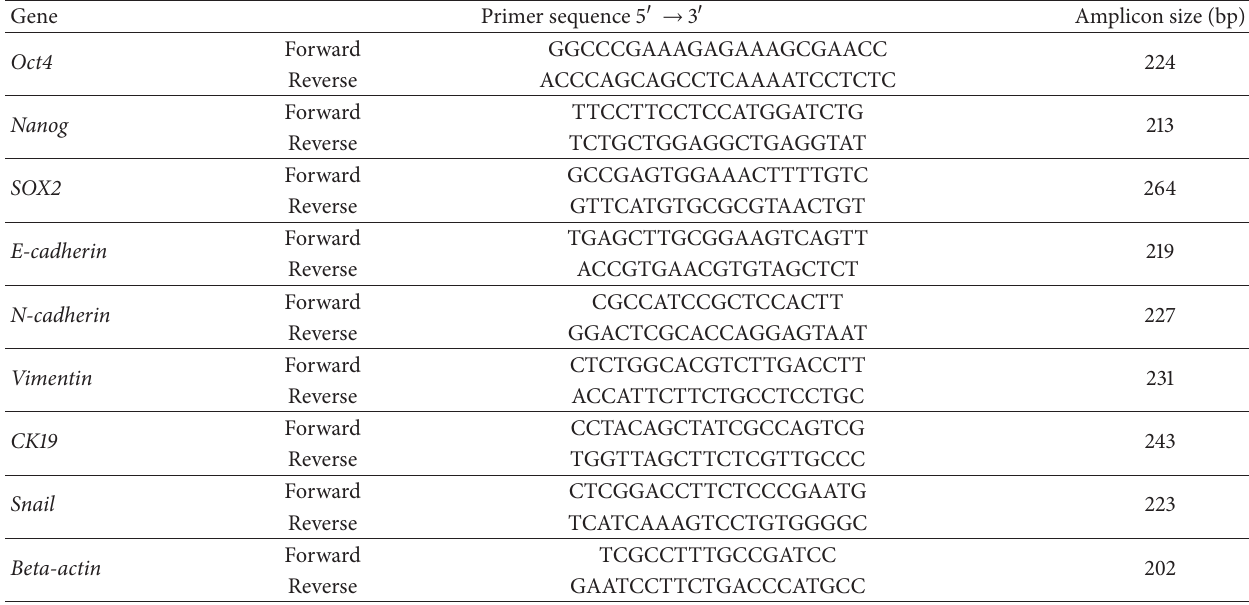
Table 1: Primers sequence for real-time PCR